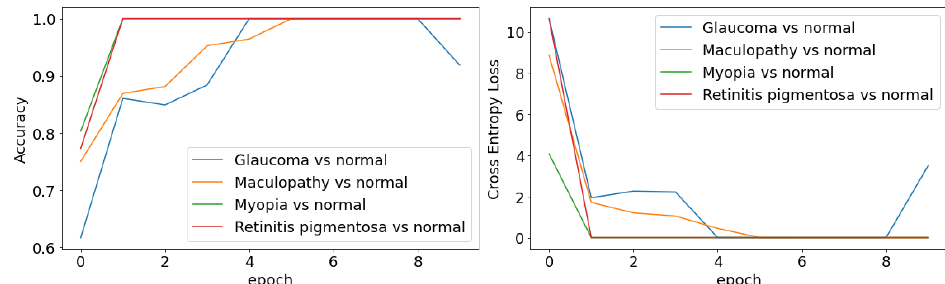
Figure 6. Learning curves of the binary